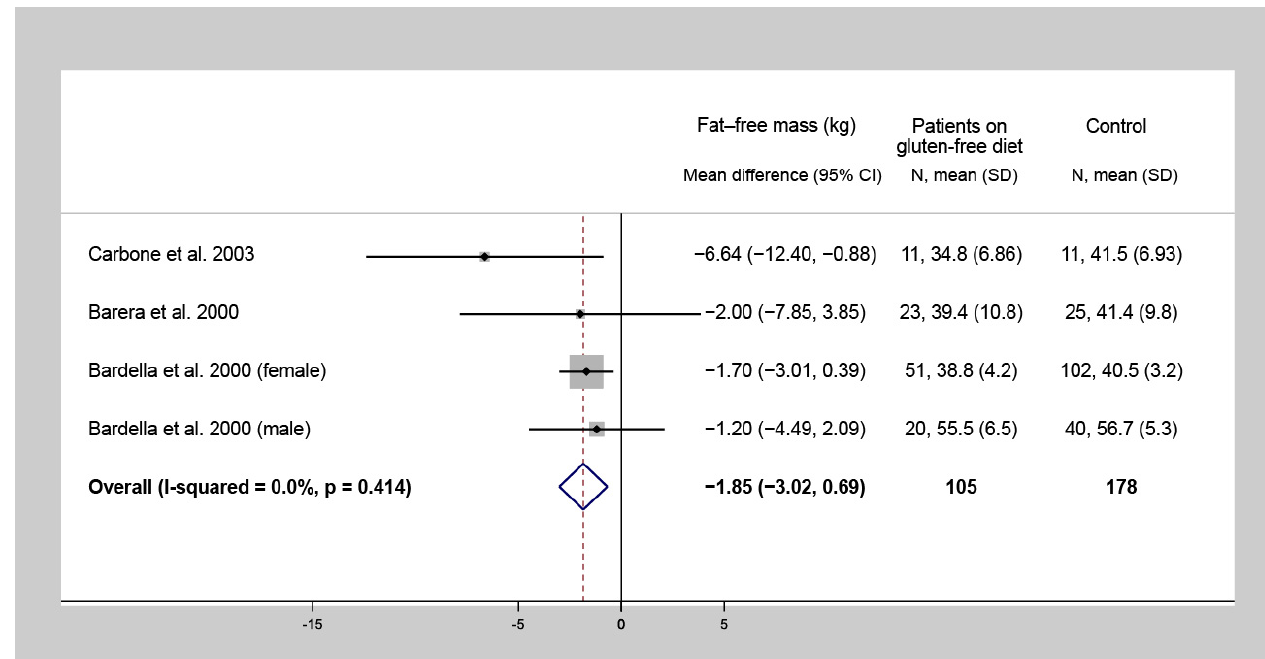
Figure 4. Forest plot of studies comparing fat-free mass of celiac disease patients on a gluten-free diet for at least one year to that of non-celiac control subjects (a negative number indicates a lower fat-free mass of the celiac population compared to controls). N: Number of patients.